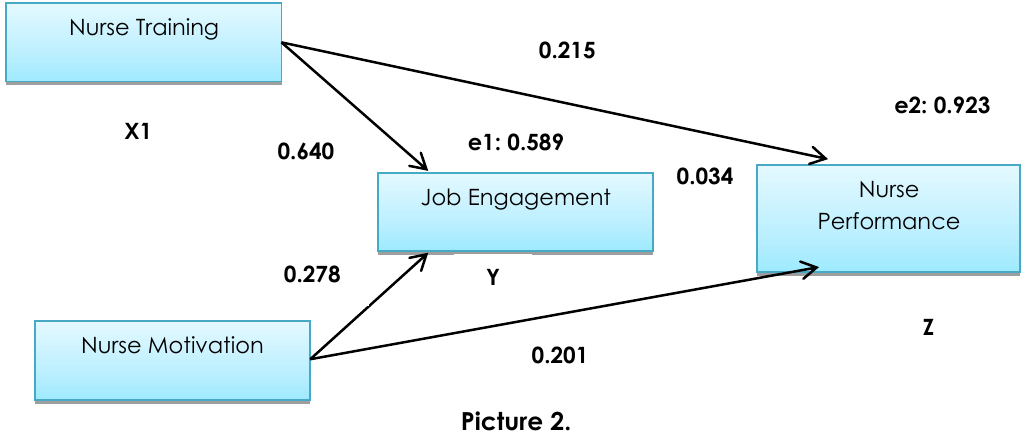
Picture 2. Model Framework for Hypothesis Test Results Effects between Employee Training, Work Motivation, Job Engagement, and Nurse